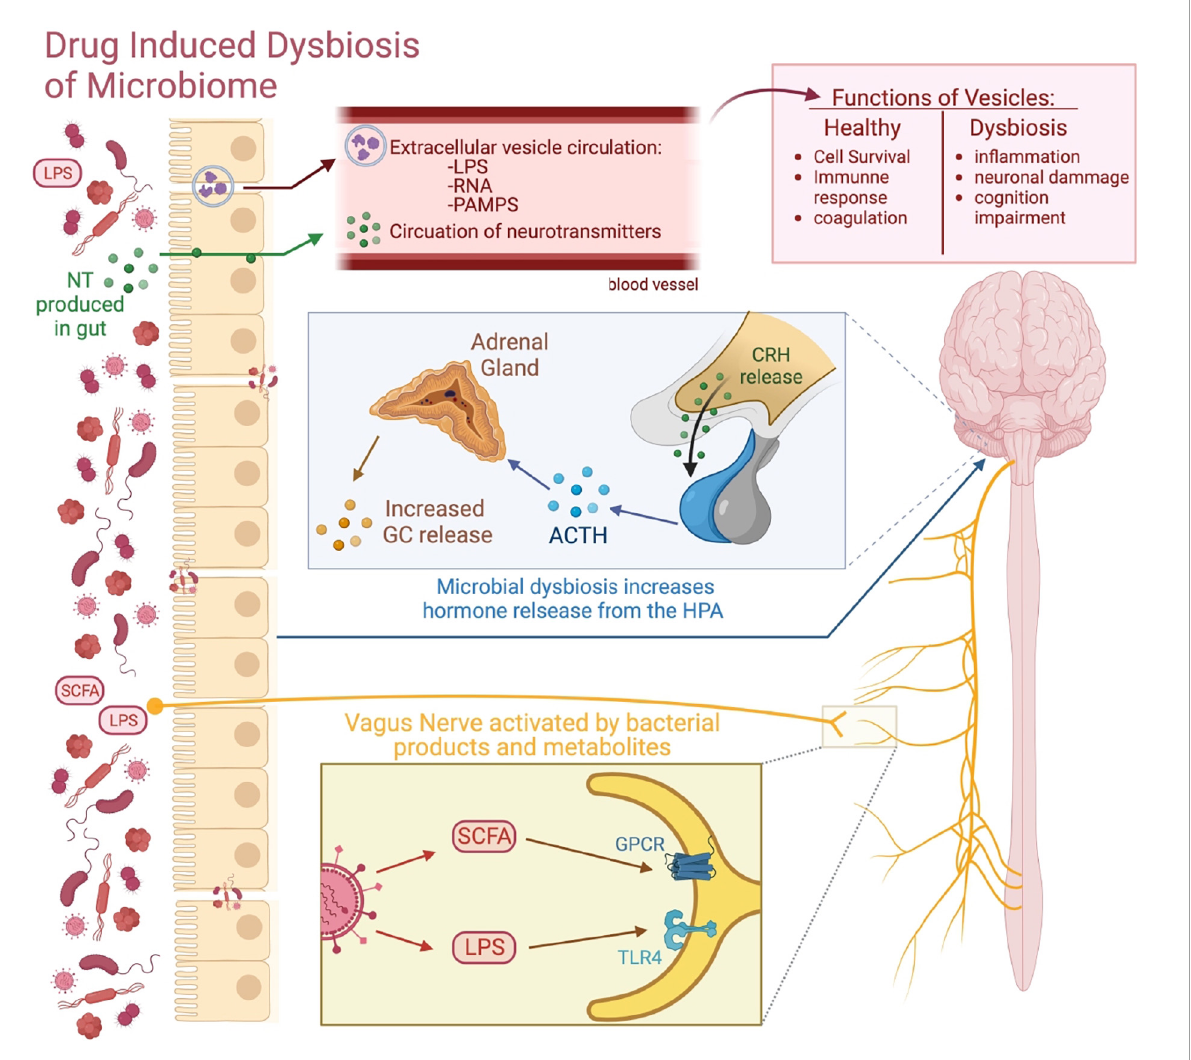
FIGURE2 Routes of communication between the gut microbiome and the brain. This figure visually depicts the different routes of communication between the gut microbiome and the brain. Microbial communication with secreted neurotransmitters (NT) and microbiome-derived EVs allow for the transfer of bacterial products into the CNS. The gut microbiome can influence brain activity through the HPA axis by influencing the secretion of its various hormones. The vagus nerve acts as a neuroanatomical connection between the gut and the CNS, as gut bacterial products and metabolites such as LPS and SCFAs can bind to their receptive receptors expressed on the vagus nerve and send signals to